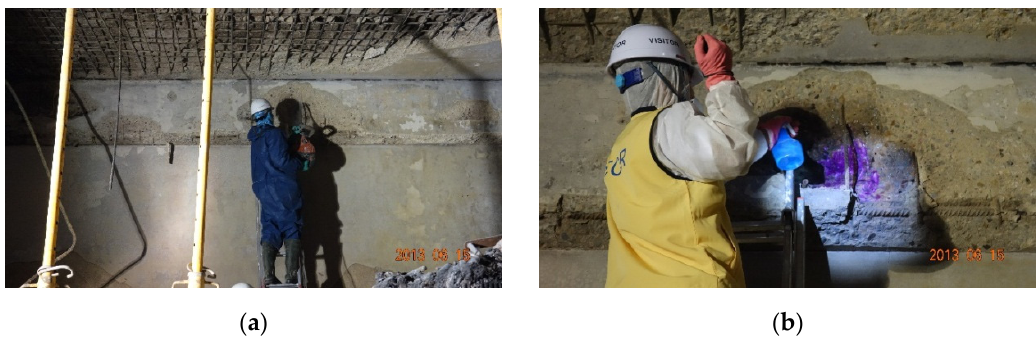
Figure 11. Preparation of the surface of Girder #1 ( a ) and application of phenolphthalein indicator ( b ).